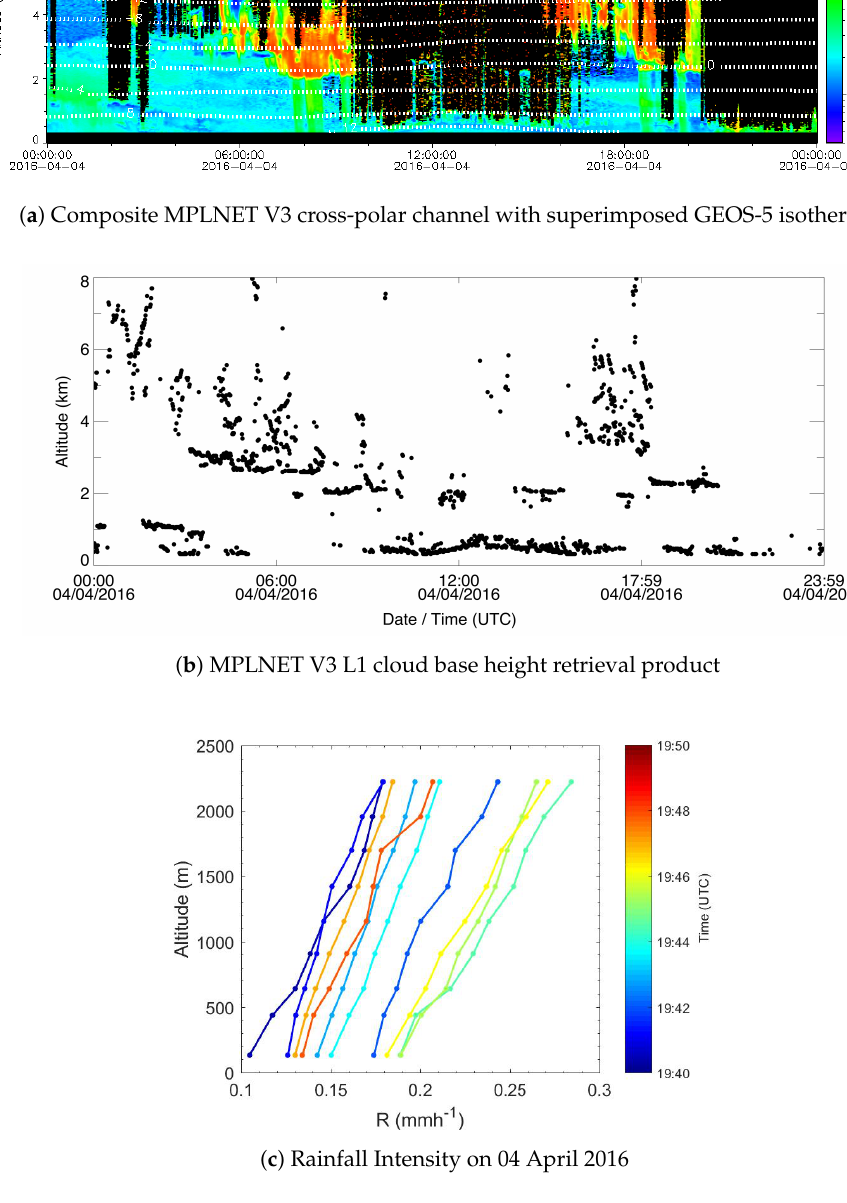
Figure 2. Vertically-resolved rainfall intensity computations at different measurement times for UPC MPLNET station on 4 April 2016. ( a ) MPL cross-polar channel signal; ( b ) cloud base height automatically retrieved by V3 L1 Cloud algorithm; ( c ) vertically-resolved rainfall intensities, computed with the analytical model solution using disdrometer data and V3 L1 cloud base height retrieval, from 7:40 p.m. UT to 7:50 p.m.